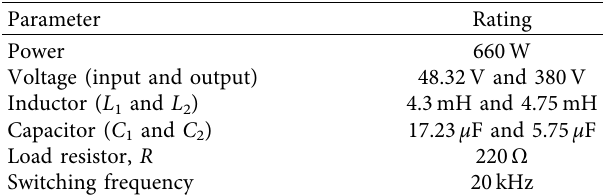
Figure 3: I-V and P-V characteristics of 660W PV modules. Table 2: Converter design